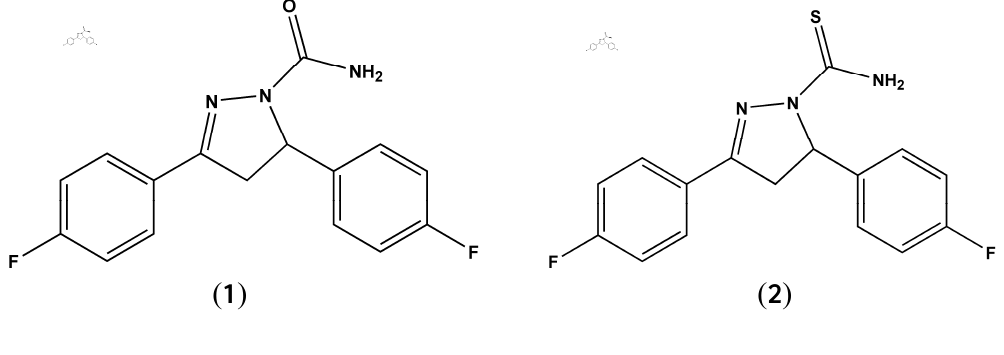
H F N O and ( 2 ) C 16 13 2 3